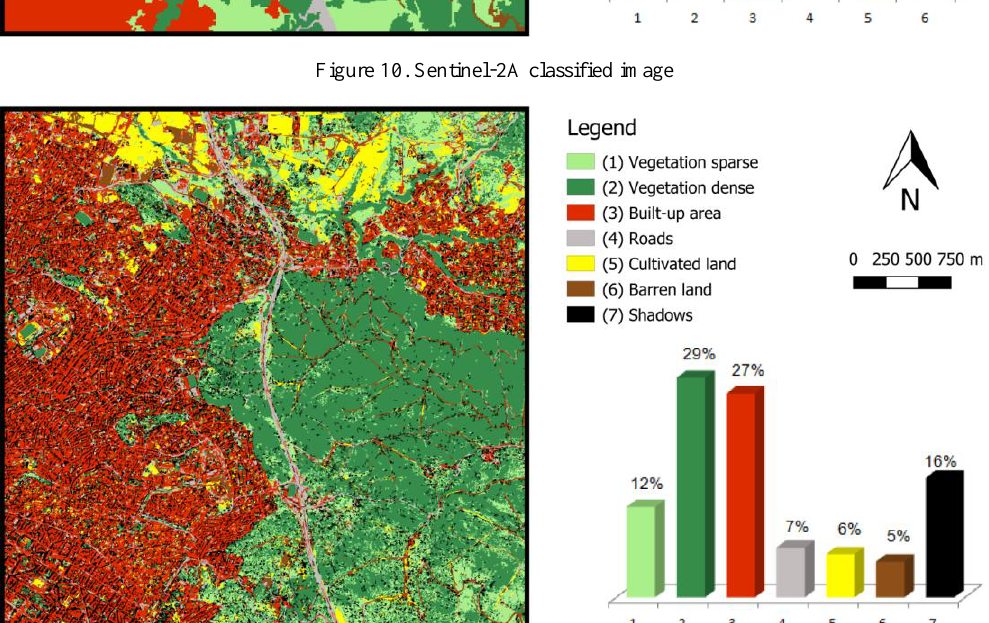
Figure 11. QuickBird classified image